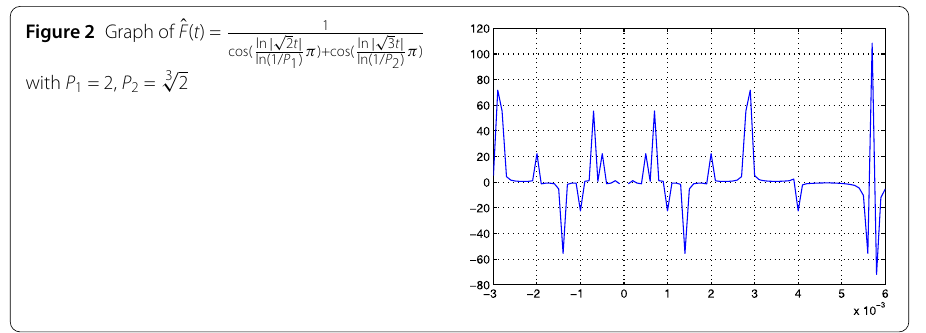
Figure 2 Graph of ˆ F ( t ) = with P 1 = 2, P 2 = 3